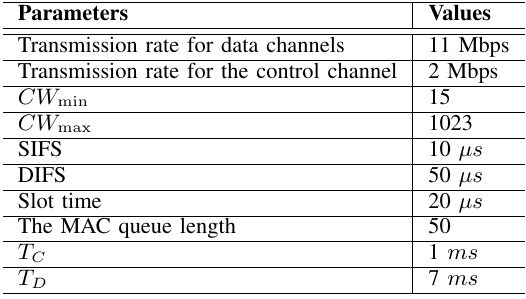
TABLE I. Simulation